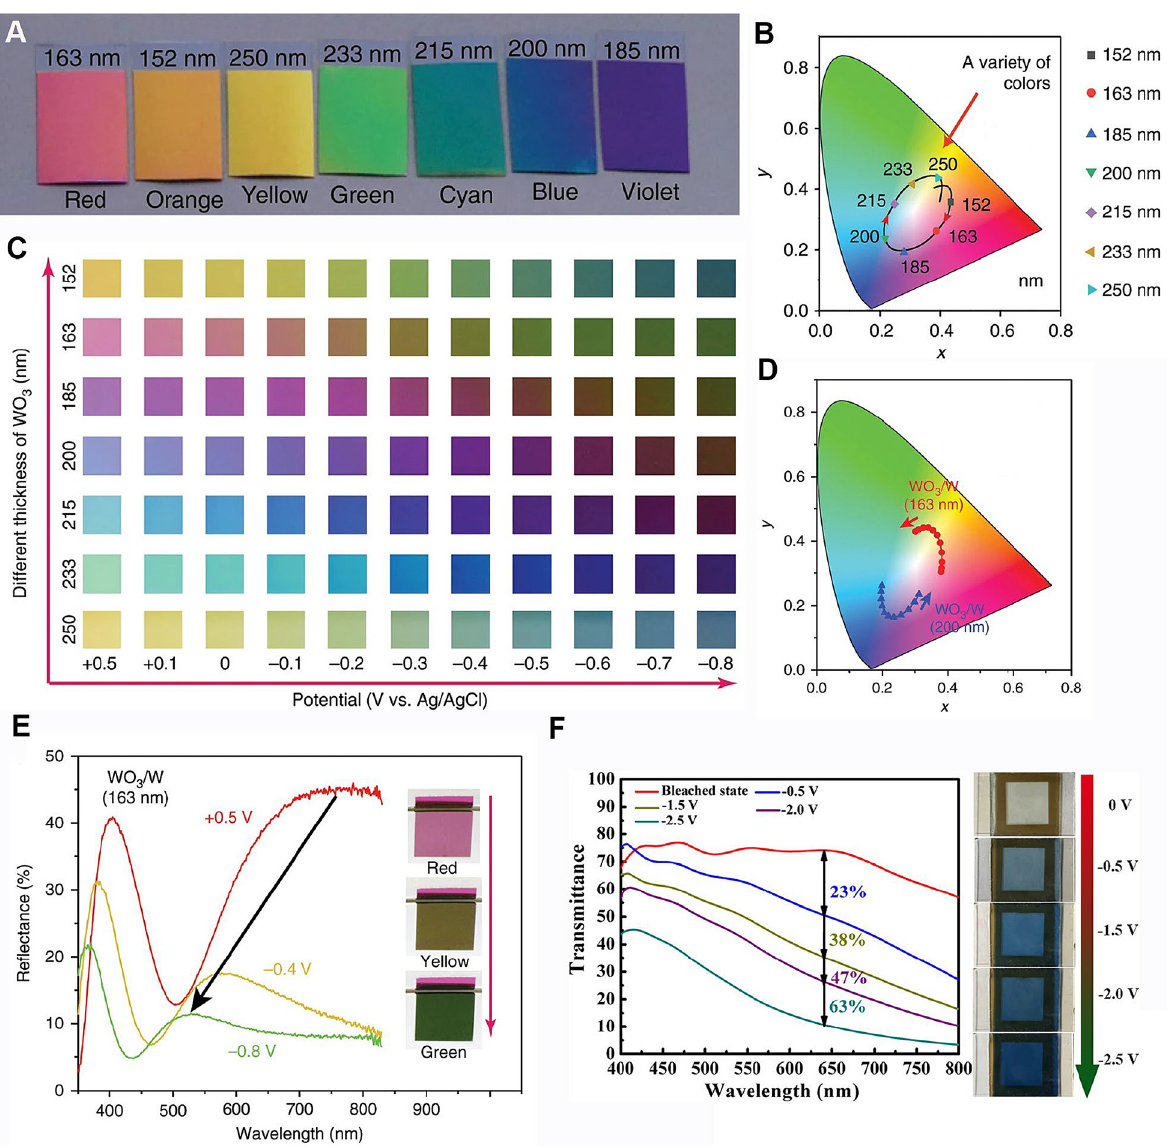
Figure 6: Demonstration of electrochromic materials having different colors and light spectra. (A) Photographs of the WO 3 /W electrodes having different thicknesses of the WO 3 layer. (B) CIE color coordinates of the WO 3 /W electrodes having different thicknesses of the WO 3 layer. (C) Color gallery obtained from the WO 3 /W electrodes under different voltage biases. (D) CIE color coordinates of the 163/200-nm-thick WO 3 /W electrode under different voltage biases. (E) Re fl ectance spectra and photographs of the 163-nm-thick WO 3 /W electrode under different voltage biases. (A – E) Reproduced with permission from Ref. [17]. Copyright 2020,